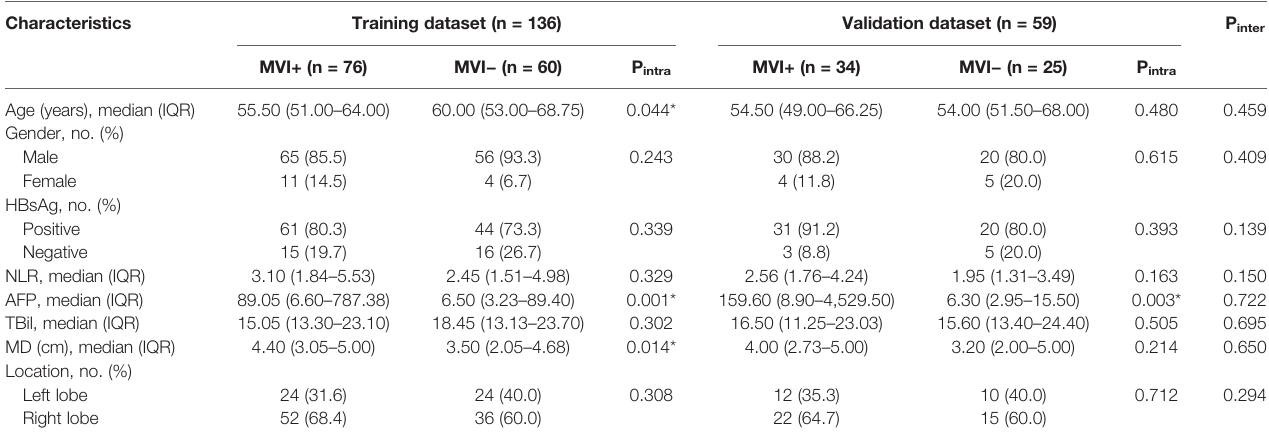
TABLE 2 | Patients ’ characteristics in the training and validation